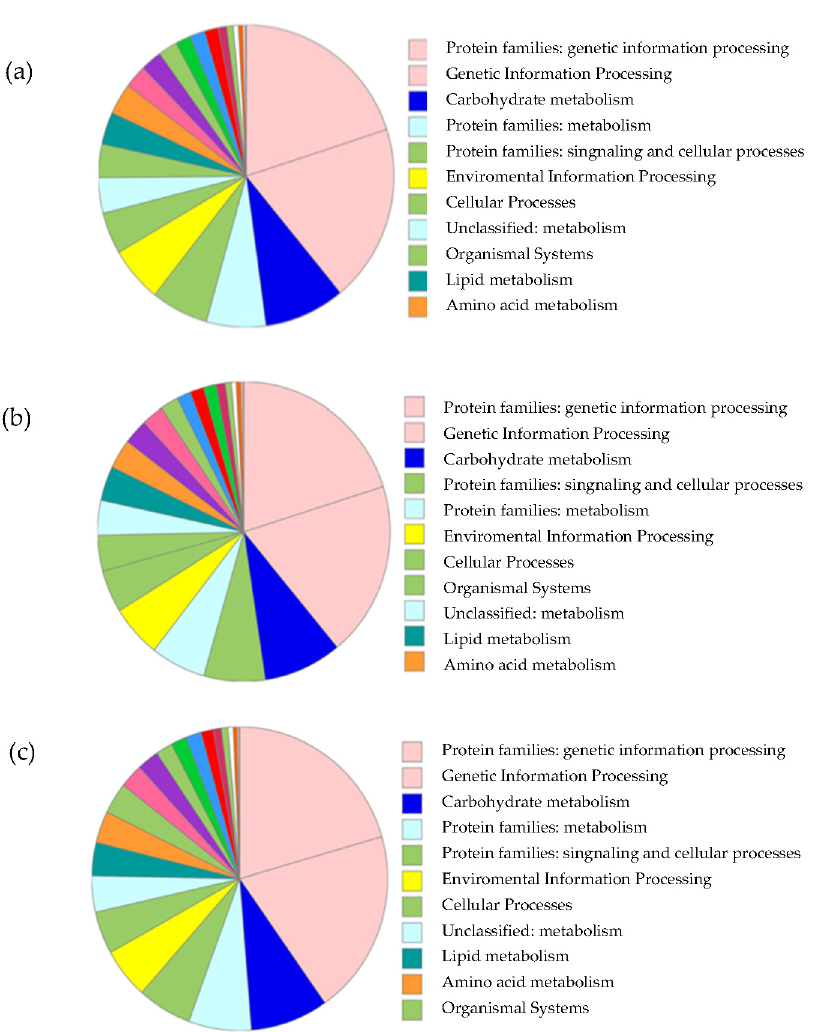
Figure 6. Classification of KEGG function on the flower part of three species Hoya ; ( a ) H. cagayanensis ; ( b ) H. lacunosa , and ( c ) H. coriacea. Unigen functions were identified and categorized using GhostKOALA software over the entire eukaryotic database.